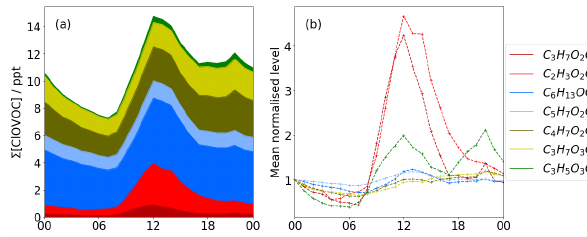
Figure 3. Diurnal profiles of Cl VOCs. (a) Stacked plot showing total Cl VOC concentration. (b) The first data point of each diurnal trace is mean normalised to 1.0. Reds show photochemical dom- inated signals with maxima at midday, whereas yellow and blue traces show a more typical diurnal concentration profile associated with changes in boundary layer height, indicating that these species have longer